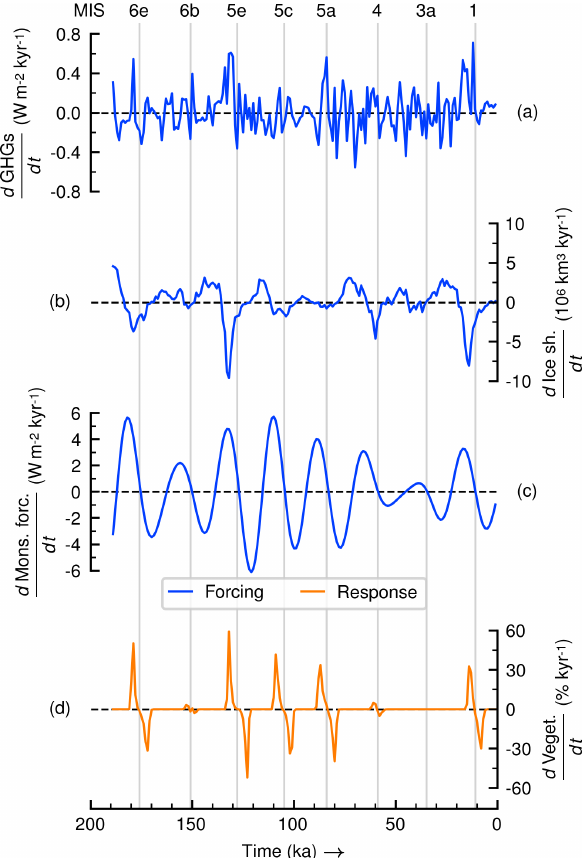
Figure 4. Rates of change of forcings and modelled response in control experiment E0: (a) GHG radiative forcing change from PI era, (b) global ice sheet volume, (c) monsoon forcing index and (d) simulated vegetation cover fraction in the Sahara grid box. Ver- tical lines show maxima of monsoon forcing index and are labelled using MIS names on top.